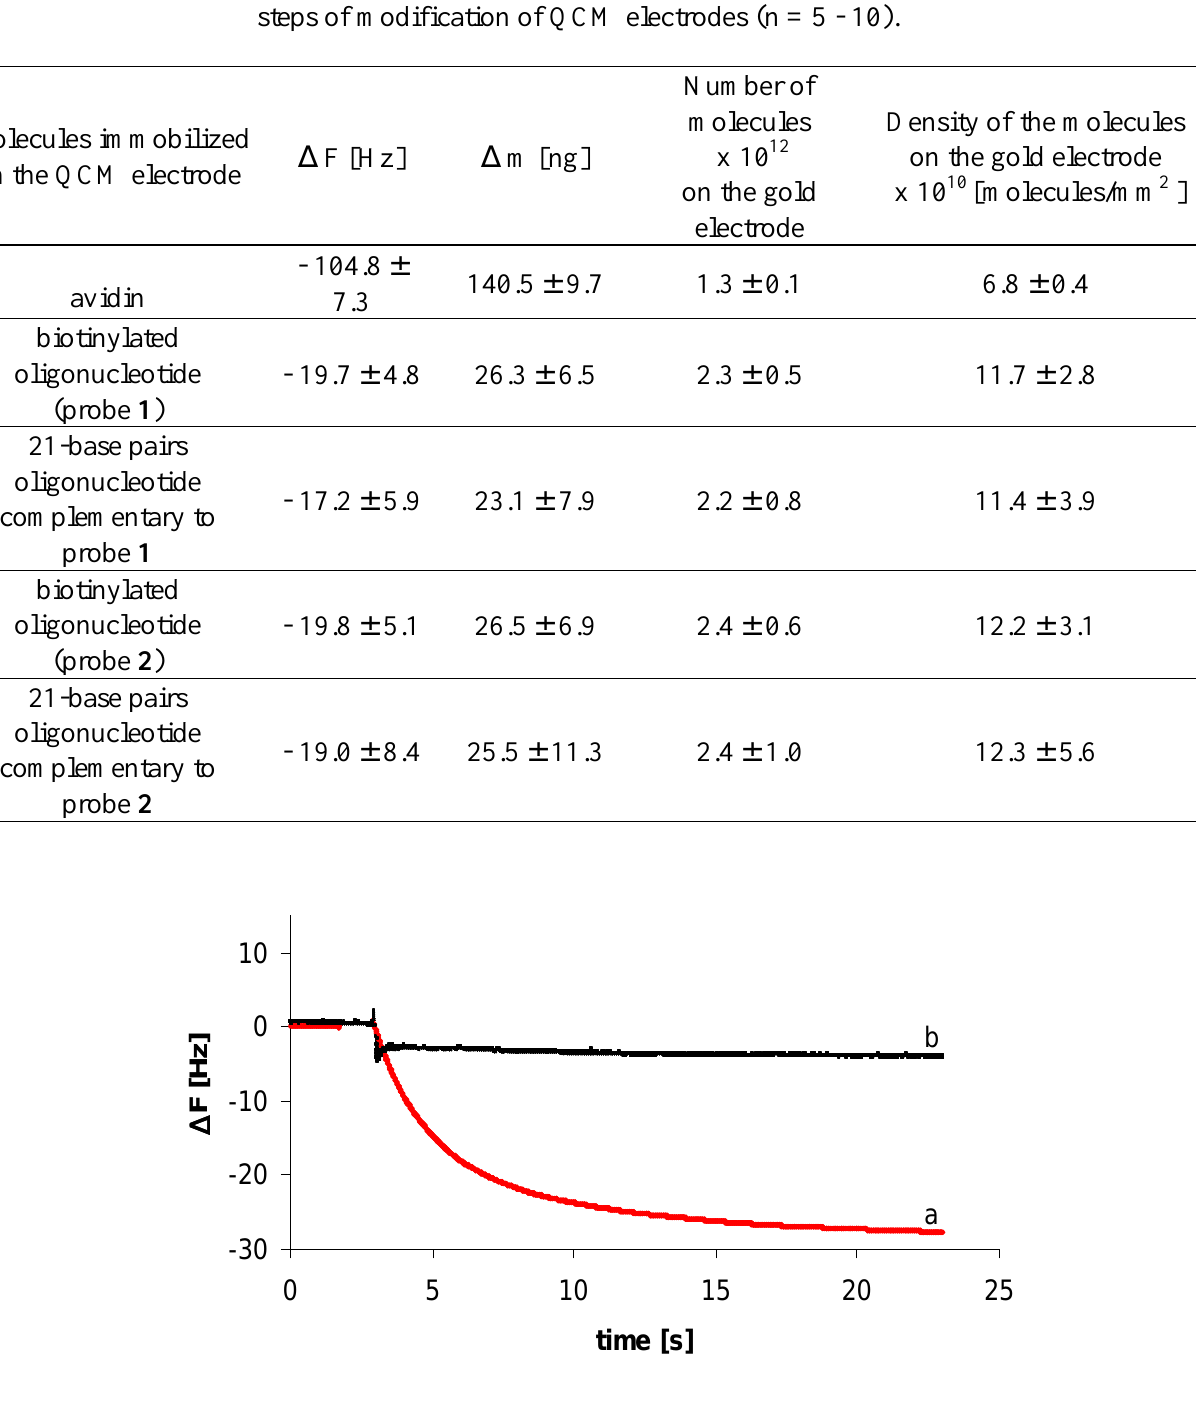
Figure 4. Frequency change of QCM electrode modified with biotinylated probe 1 at the presence of: (a) complementary oligonucleotide (21-mer) (80 nM) (b) non-complementary oligonucleotide (22-mer) (72 nM) The solution composition: 27 mM HEPES, 55 mM NaCl pH 7.5; total volume in the QCM cell: , 200 m